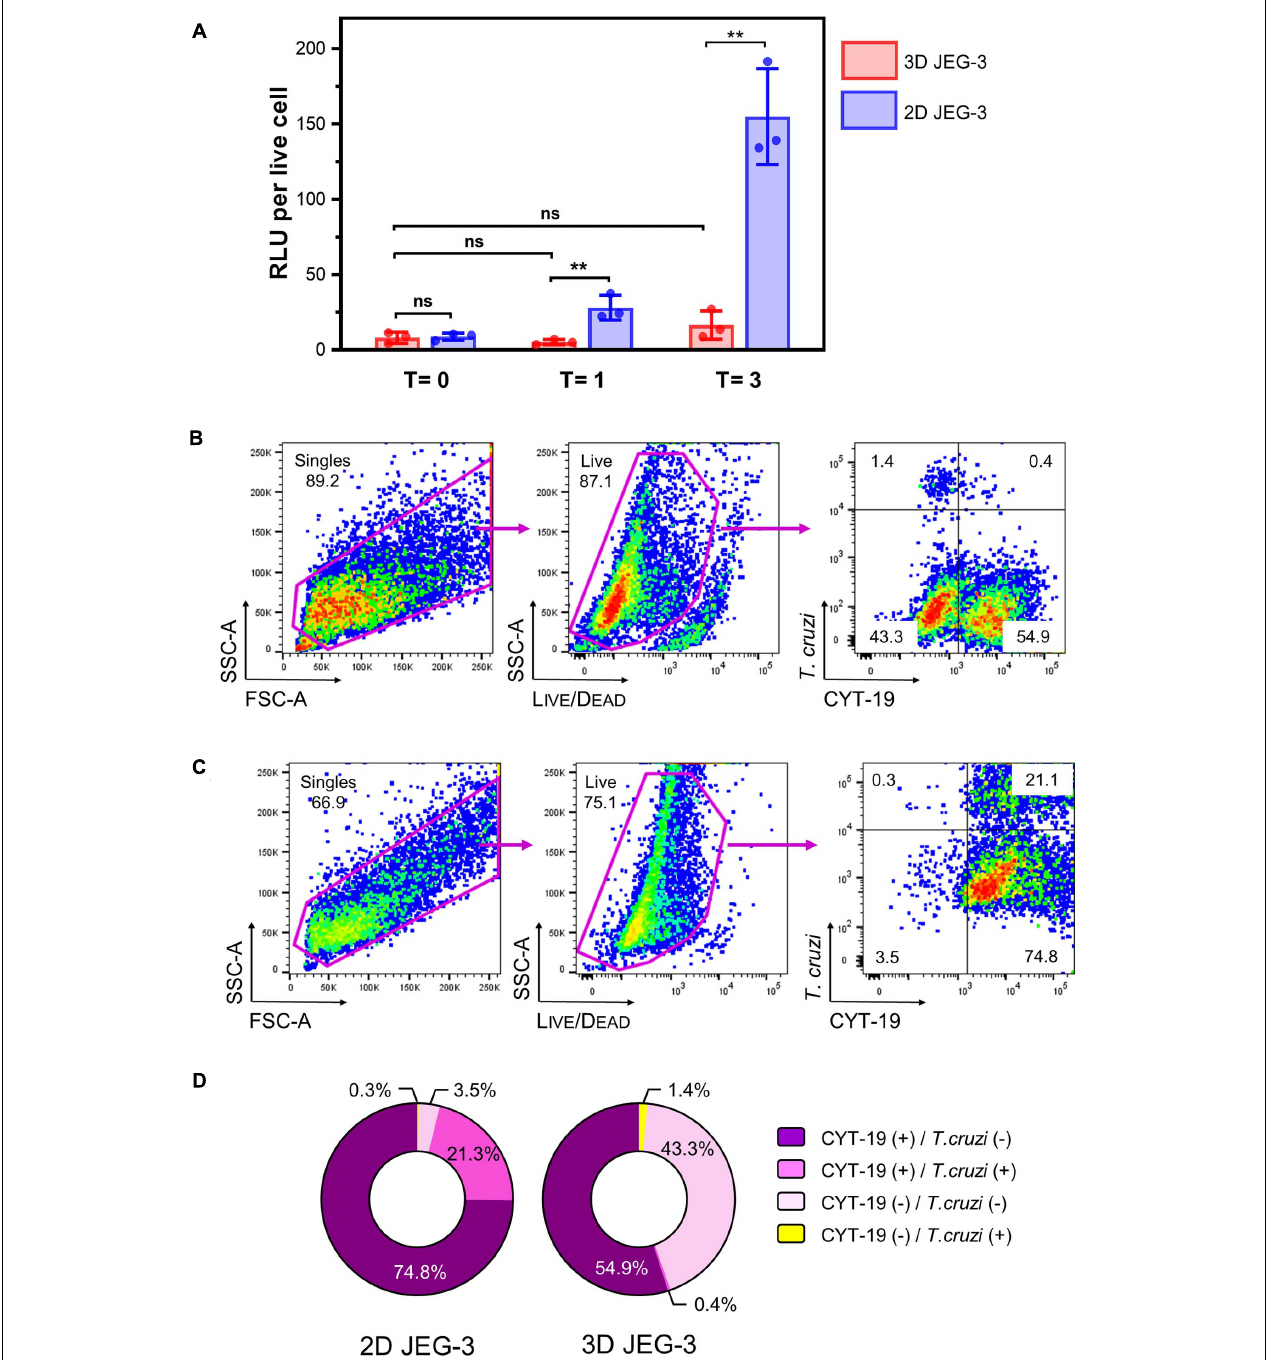
FIGURE 4 | 3D-grown JEG-3 cells resist T. cruzi infection. (A) Monolayers of JEG-3 cells (2D JEG-3) grown in 96-well plates and spheroids (3D JEG-3) transferred from the RWV bioreactor to 96-well plates, were infected with T. cruzi- luminescent parasites at a ratio of 5 parasites per live cell. The infection was conducted under static conditions and monitored over time by measuring intracellular nanoluciferase activity at 0 ( T = 0), 1 ( T = 1), and 3 ( T = 3) dpi. Luminescence was quantitated in relative light units (RLU) and normalized to the number of live cells. Data represent the mean ± SD of three technical replicates and is representative of 3 independent experiments. Asterisks indicate statistically significant differences calculated by an unpaired t -test. ** P ≤ 0.01; ns: non-significant. (B) 3D JEG-3 cells were infected with CellTrace TM Far Red- labeled trypomastigotes at a ratio of 5 parasites per live cell under slow rotation in the RWV bioreactor. Sixteen hours post-infection, cells were detached from the beads, stained for CYT-19 and analyzed by flow cytometry. The gating strategy used to identify singles and exclude dead cells (based on LIVE/DEAD TM violet dye staining) is shown. Data are representative of two independent experiments. (C) Same as in (B) but infection was conducted in 2D cultured JEG-3 cells. (D) Pie charts illustrating the distribution of cell populations from 2D and 3D JEG-3 cells according to infectivity and CYT-19 status.